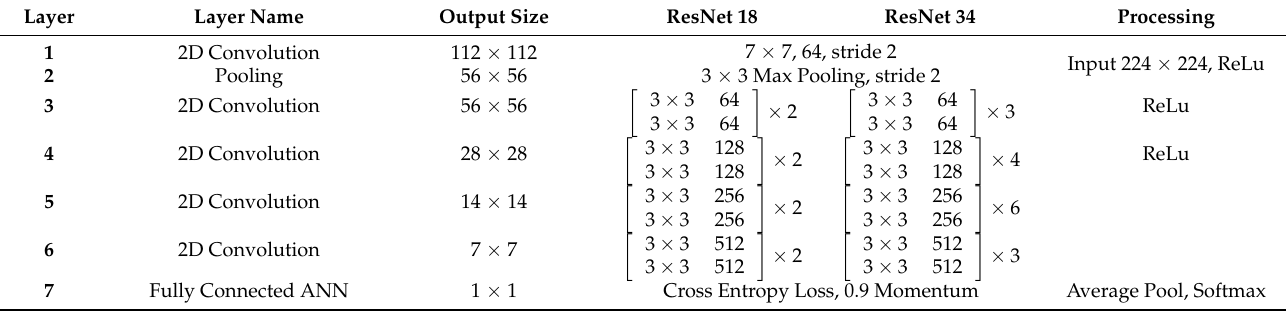
Table 2. The architectures of the deep residual neural networks (ResNet 18 and ResNet 34) used for classification of on 400 sUAS images collected of cattle, horses, white-tailed deer, and Canada Geese, a subsample of the 1288 images collected that contained